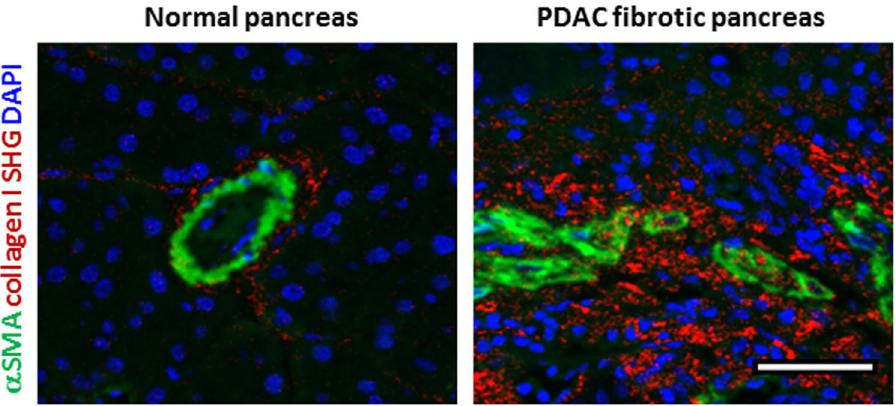
Figure 3. α SMA is highly expressed and co-localises with collagen-I in PDAC tissues but α SMA expression is markedly decreased in normal pancreatic tissues from mice. Immunofluorescence images combined with second harmonic generation (SHG) signal of normal and PDAC tissues from mice. Scale bar 100 μ m. Collagen I SHG shown in red.